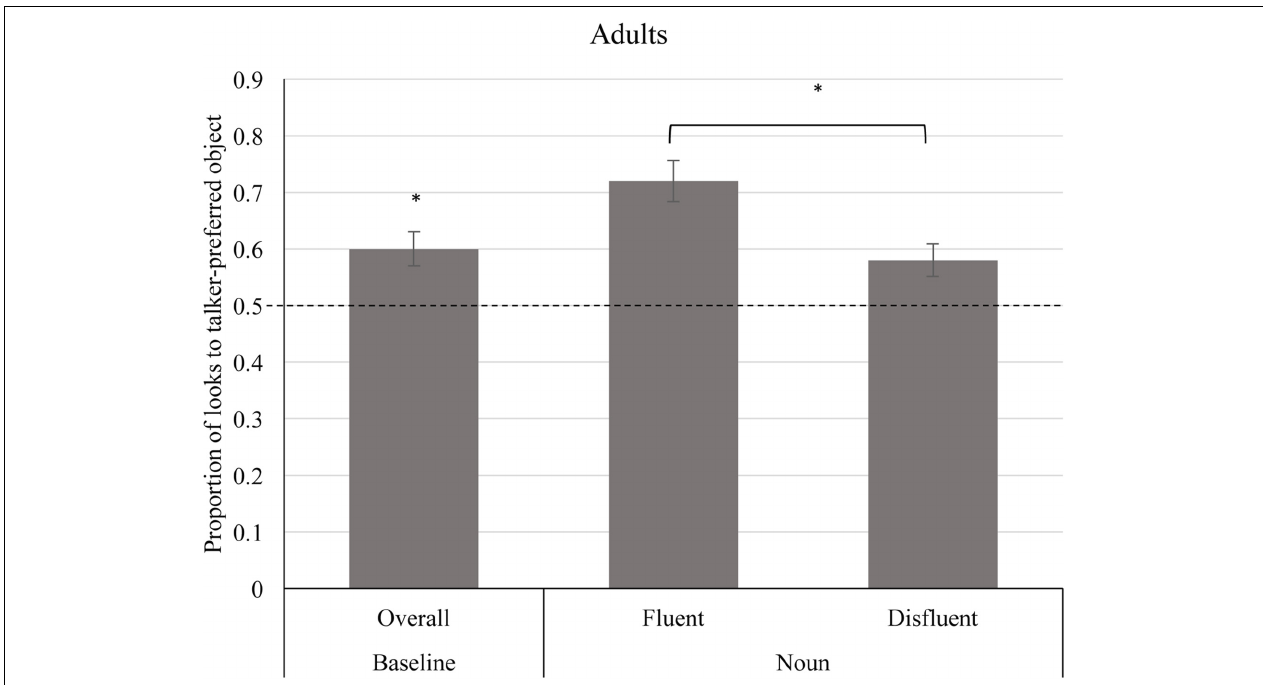
FIGURE 3 | Average proportion of time fixating talker-preferred objects during the baseline interval and noun interval for adult age group. The average proportion of time looking to the talker-preferred object was significantly greater than chance (0.50) during the baseline interval ( p < 0.001). There was a significant effect of fluency during the noun interval ( p = 0.041), such that adult participants directed a greater proportion of looking time to the talker-preferred object during the noun interval for fluent trials compared to disfluent trials. Error bars depict standard errors. A single asterisk represents significant differences at the p < 0.05